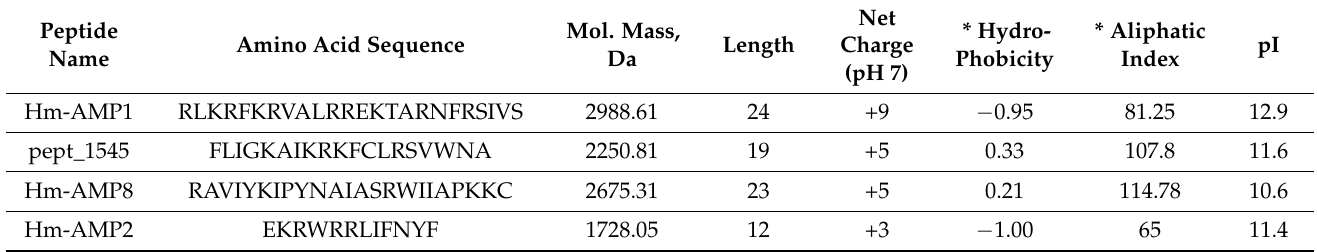
Table 1. Physical-chemical characteristics of cationic antimicrobial peptides (CAMPs) used in this